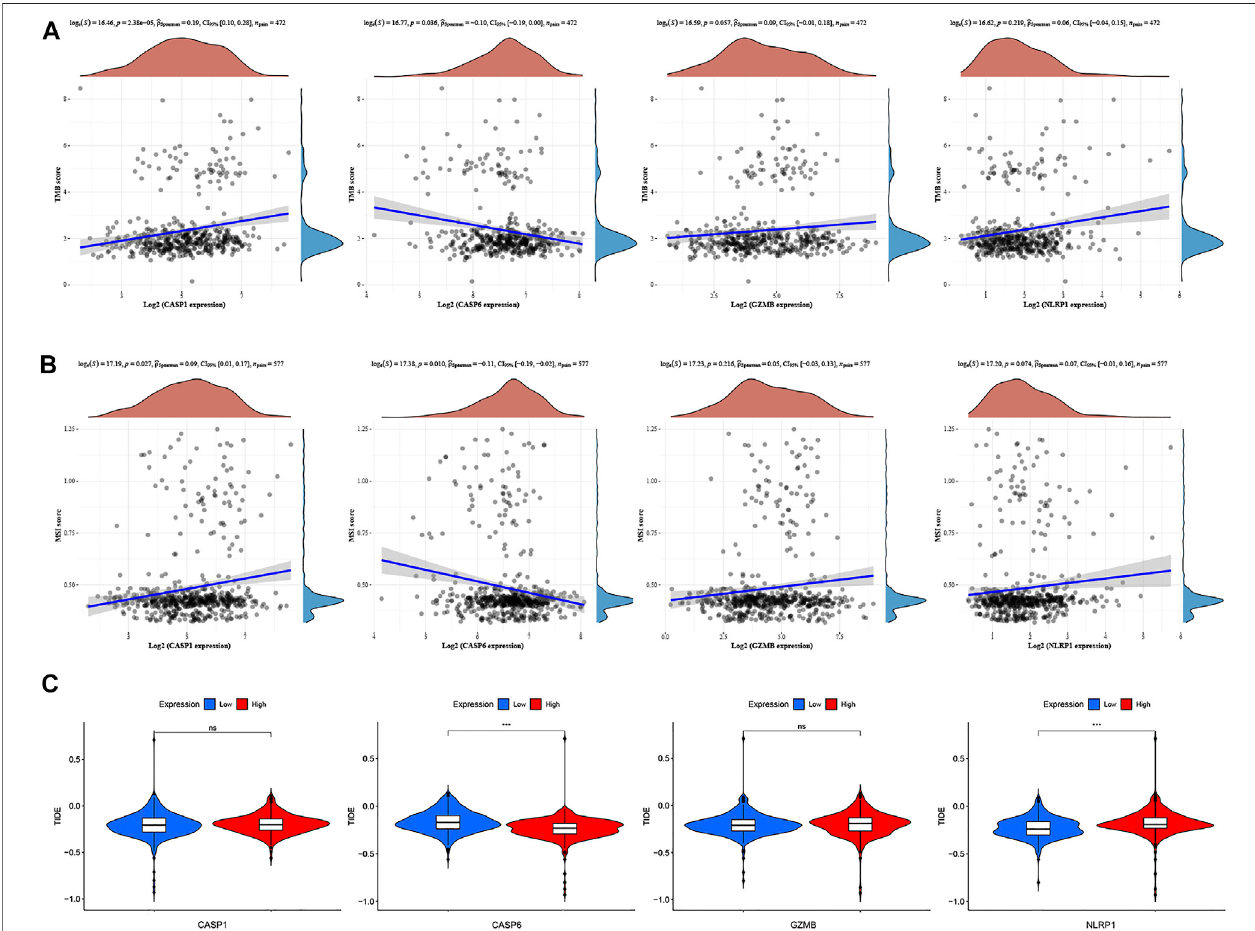
FIGURE 13 | TMB, MSI, and cancer immunotherapy response analysis with four PRG signatures. (A) Correlation between four PRG signatures and TMB in CRC. (B) Relationships between four PRG signatures and MSI. (C) Relationship between four PRG signatures and TIDE.